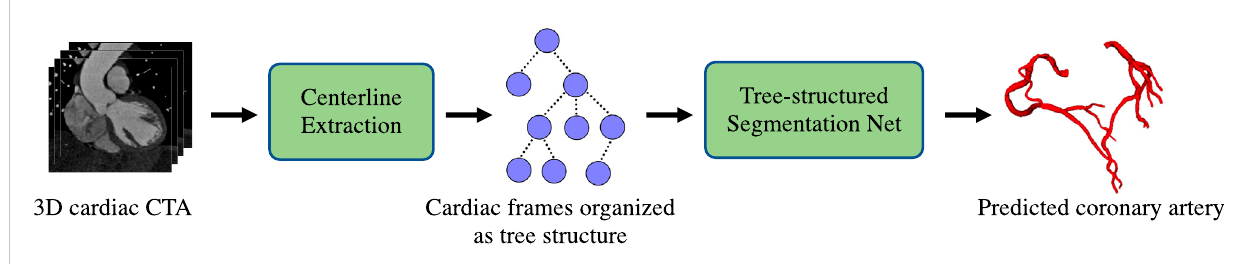
FIGURE 5 Coronary artery segmentation pipeline. The fi rst step is centerline extraction. In this step, We fi rst utilize a pretrained 3D U-Net Çiçek et al. [44] to generate thepreliminary coronary artery. The coronary arteriesarewith complextopologies.Thus, solely using thisstepisextremelydif fi cultto